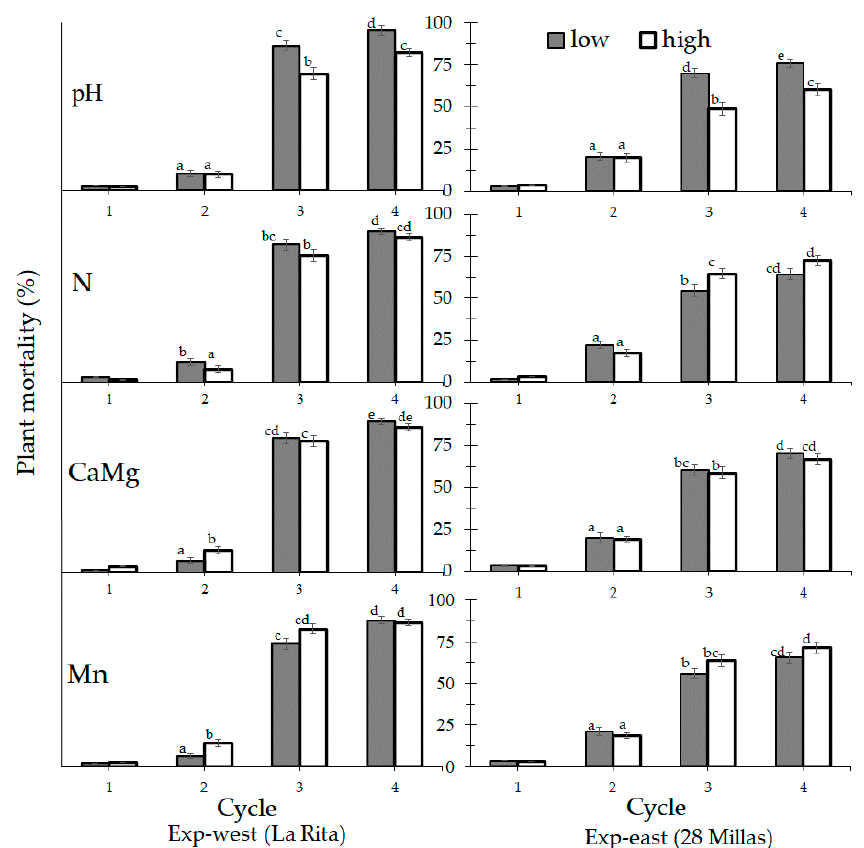
Figure 3. Plant mortality by Fusarium wilt (Foc race 1) of Gros Michel banana plants according to the management of four soil chemical properties (pH, N, CaMg and Mn) during four crop cycles in two experiments (Exp-west in La Rita and Exp-east in 28 Millas) within the Costa Rican banana region. Bars with different letter in cycle are significantly different according to the soil property. Total plants per treatment is 243 in Exp-west and 823 in Exp-east. (error bars represent the standard error).